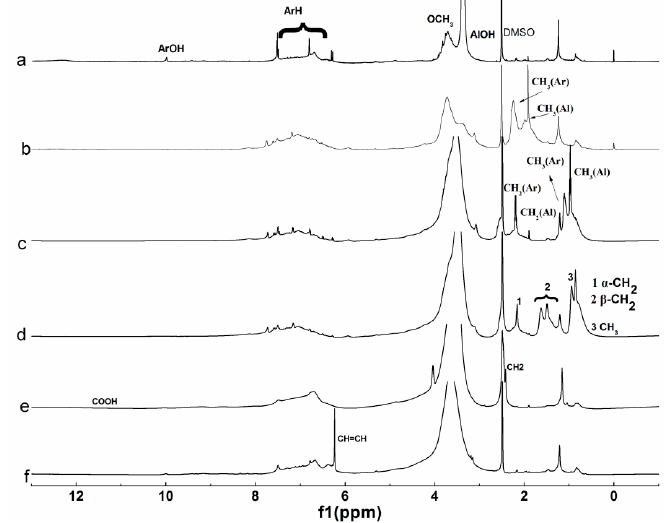
Figure 4. 1 H NMR spectra of lignin and its esters: ( a ) original lignin; ( b ) acetylated lignin (1.5 h); ( c ) propionylated lignin (1.5 h); ( d ) butyrated lignin (2 h); ( e ) succinylated lignin (2 h); ( f ) maleylated lignin (2 h).